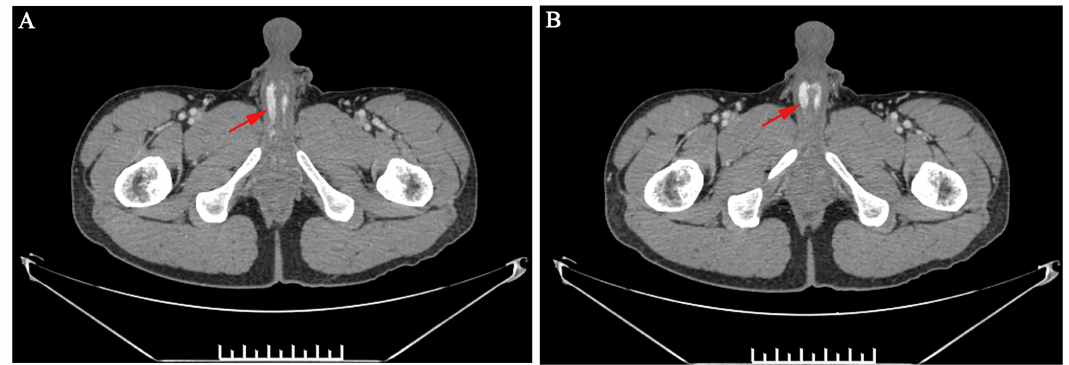
Fig. 2. Abdominopelvic computed tomography results. (A,B) Abdominopelvic computed tomography enhancement images showed a localized irregular shape and high-density imaging of the root of the corpus cavernosum (indicated by